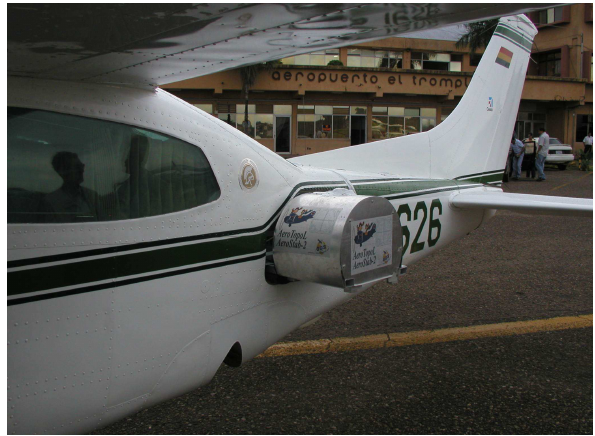
Figure 10: external mounted camera box in Bolivia, used for monitoring Coca plants